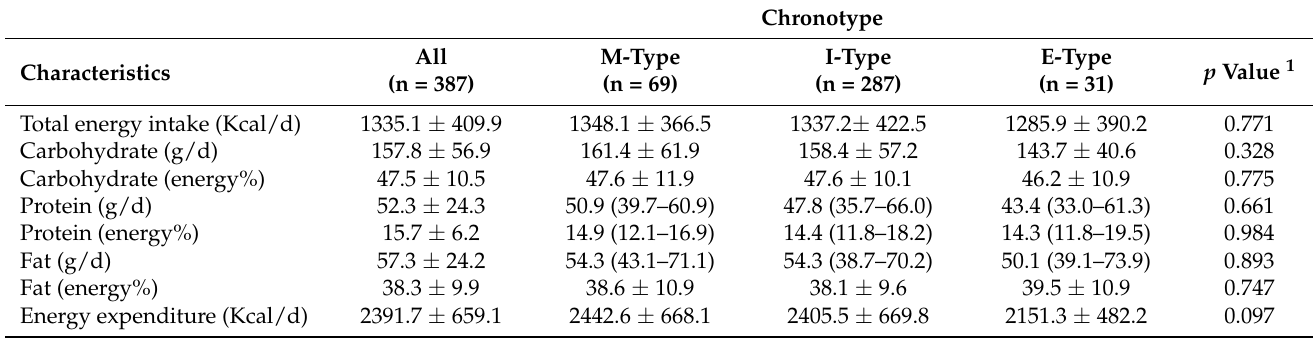
Table 3. Energy intake and energy expenditure rates for the study participants (n = 387).